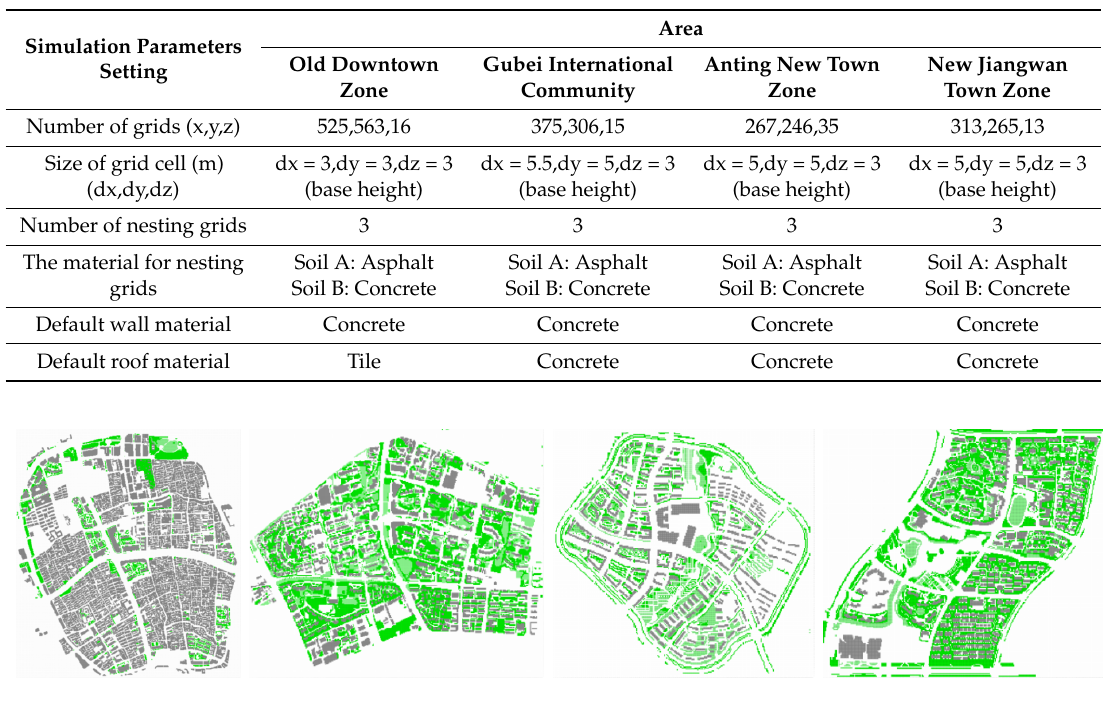
Table 3. Parameters settings of the spatial models in the four study zones.